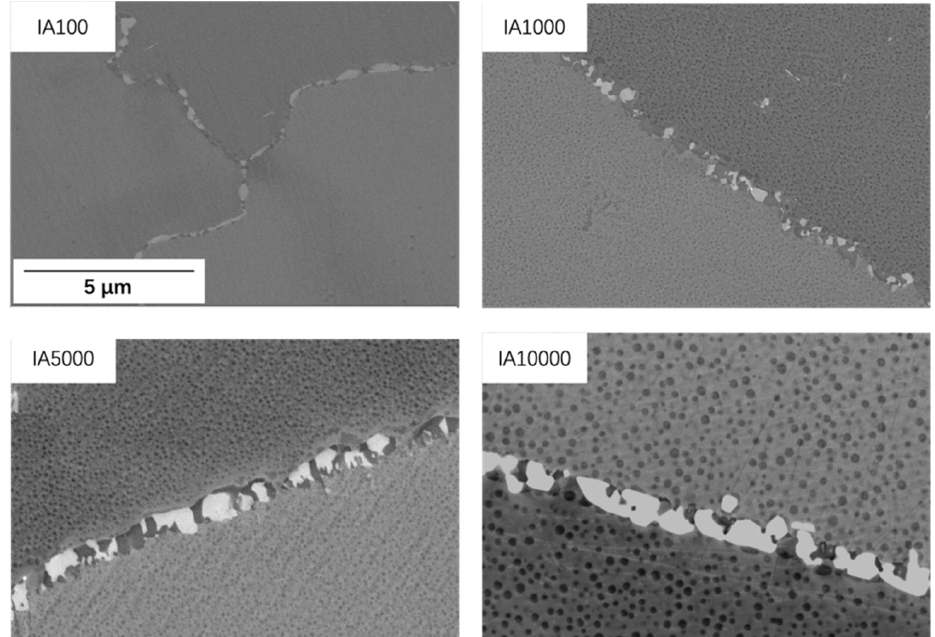
Figure 10. Micrographs of grain boundary precipitates in different isothermal aged samples. Table 3. Quantified size of M 23 C 6 in H282 after aging at 788 ◦ C. Aging Time